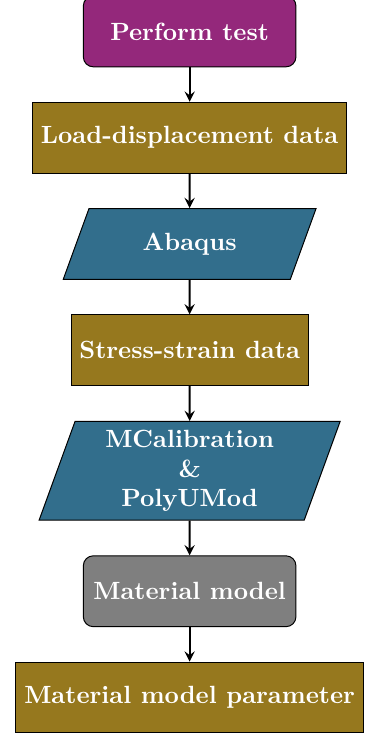
Figure 7. Workflow for the parallel network material model (PNMM). 2 nd Network: Temperature-dependent